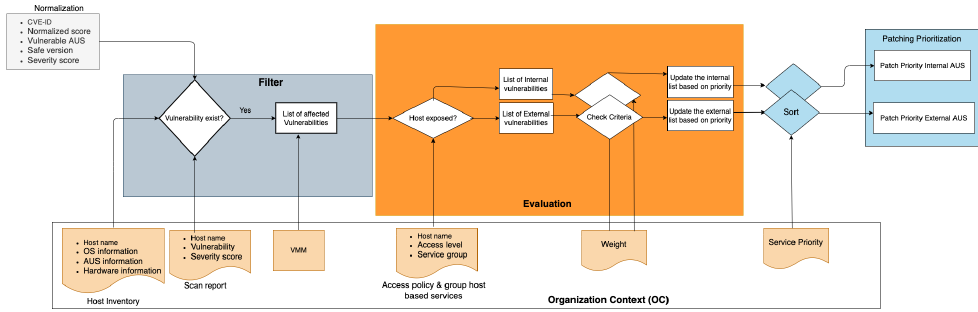
Figure 3. The phase 2—prioritization